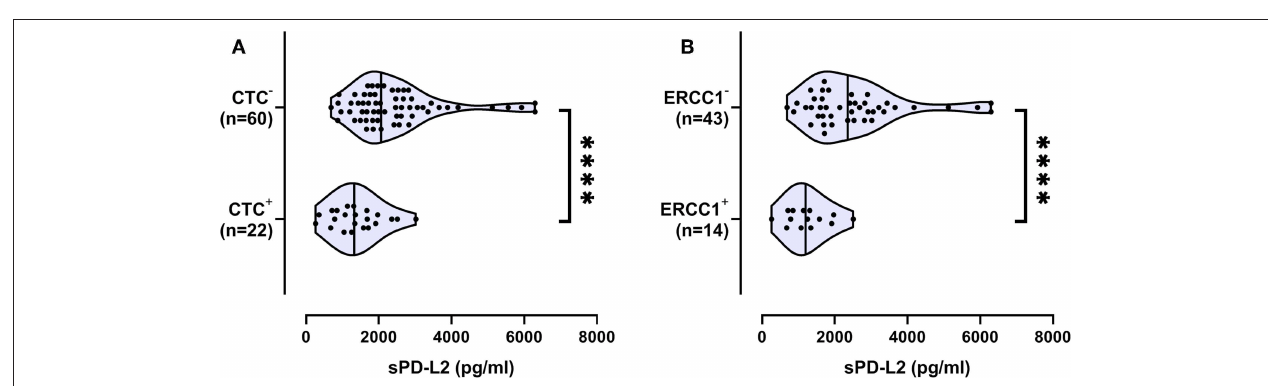
FIGURE 4 | Association of decreased sPD-L2 serum levels (pg/ml) with the presence of circulating tumor cells (CTC) and the ERCC1 + CTC subpopulation. Data about the presence of CTC (A) or ERCC1 + CTC (B) was available for 82 and for 57 EOC patients, respectively. Straight line within the violin plot indicates the median. **** p <